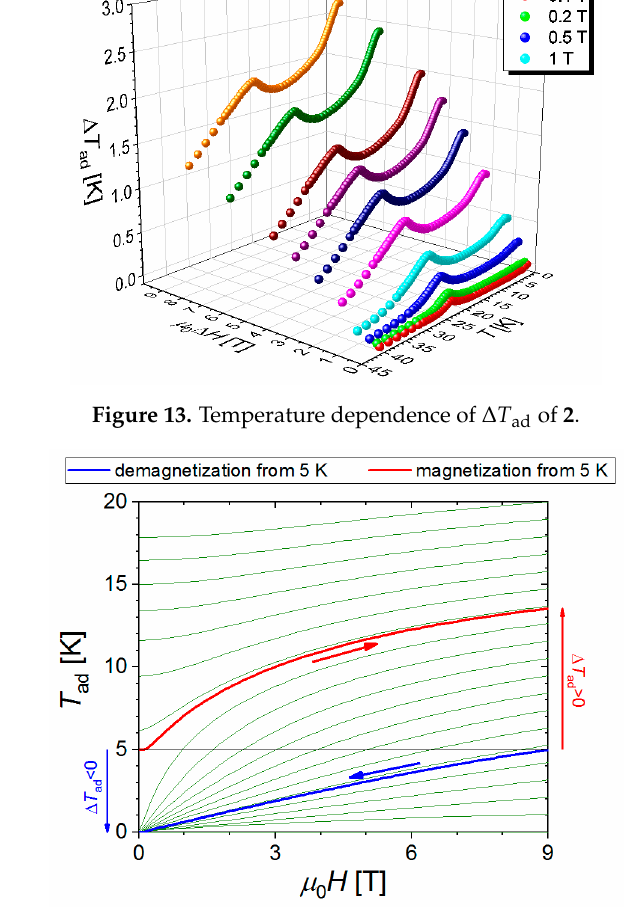
Figure 14. Adiabats obtained by solving Equation (5) with different initial conditions. Two adiabats are highlighted: the adiabat corresponding to the demagnetization process starting from 5 K and 9 T (blue), the adiabat corresponding to the magnetization process starting at 5 K and 0 T continued up to 9 T (red). The arrows show the amplitudes of the corresponding adiabatic temperature changes ∆ T ad